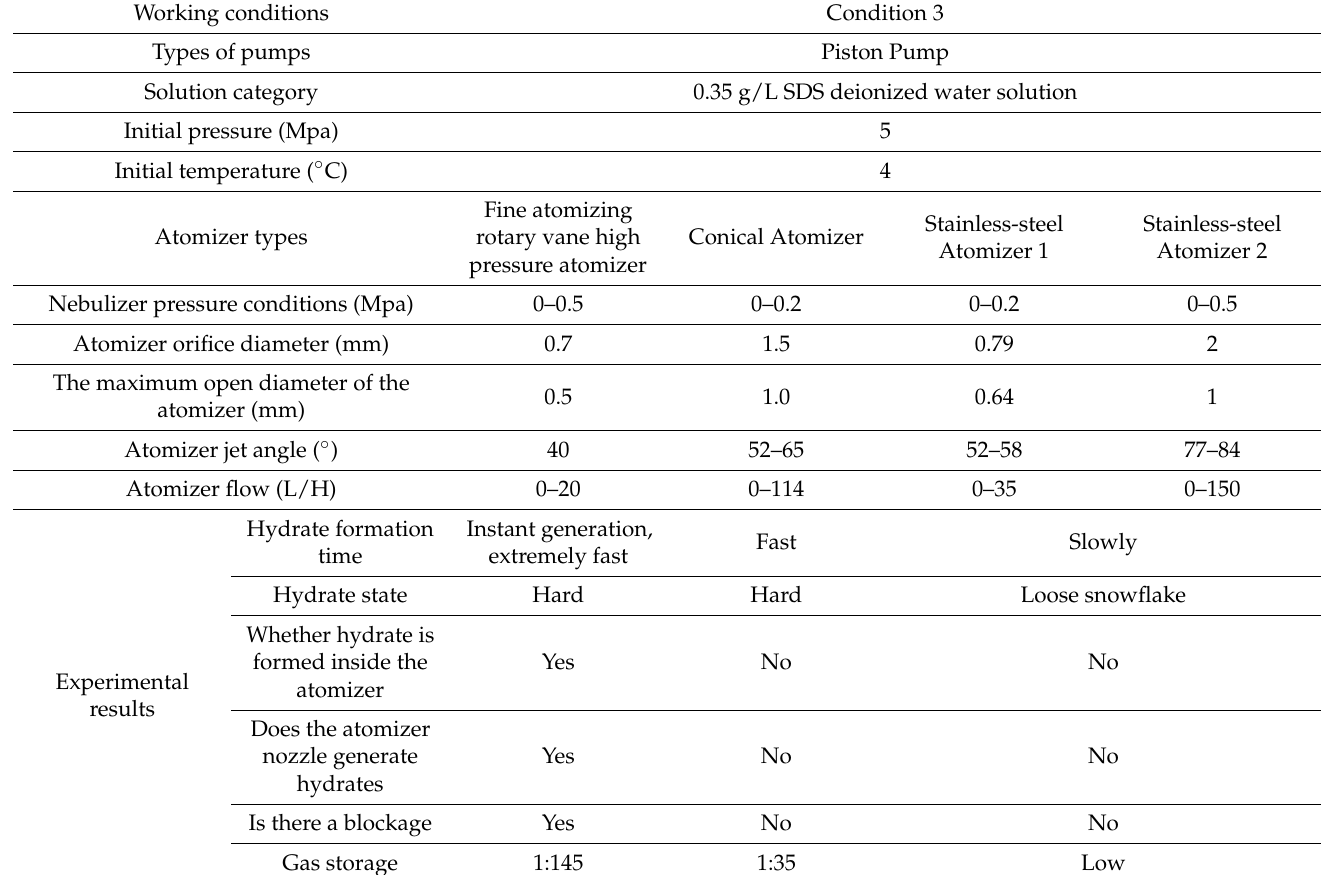
Table 5. Comparison of atomizer parameters and experiment